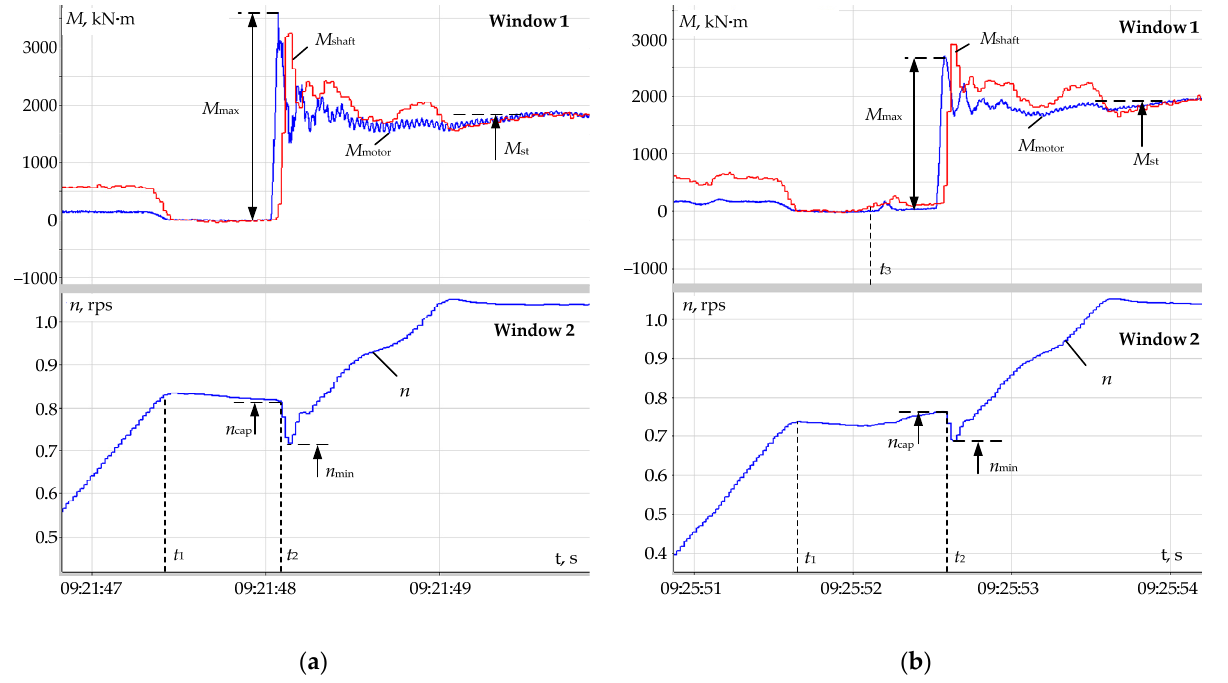
Figure 4. Biting oscillograms in the mode with fully open angular gaps ( a ) and with closed gaps ( b ): window 1—motor M motor and spindle shaft М shaft torques; window 2—motor speed n.